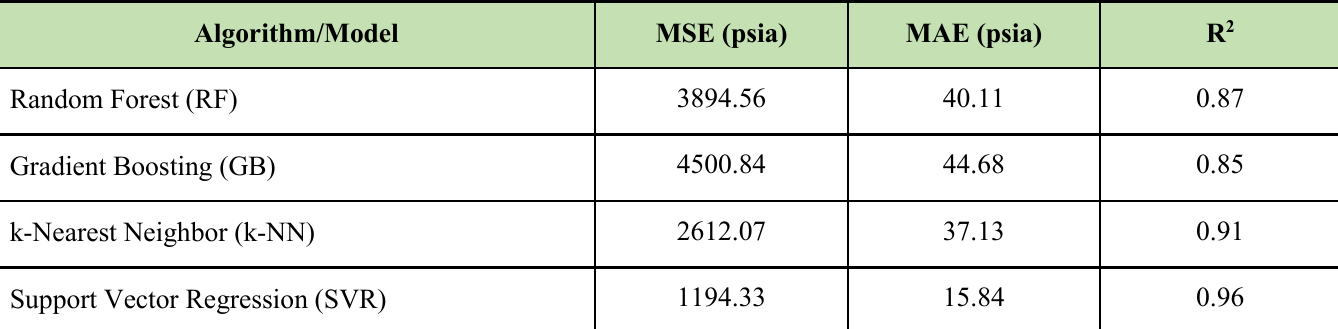
Table 1 — Performance metrics of the four classical ML algorithms (Test Case